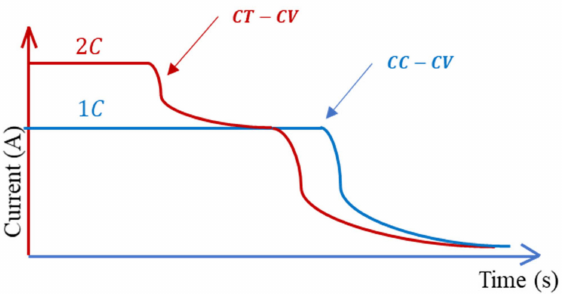
Figure 5. Schematic diagram of the Constant Temperature Constant Voltage (CT-CV)